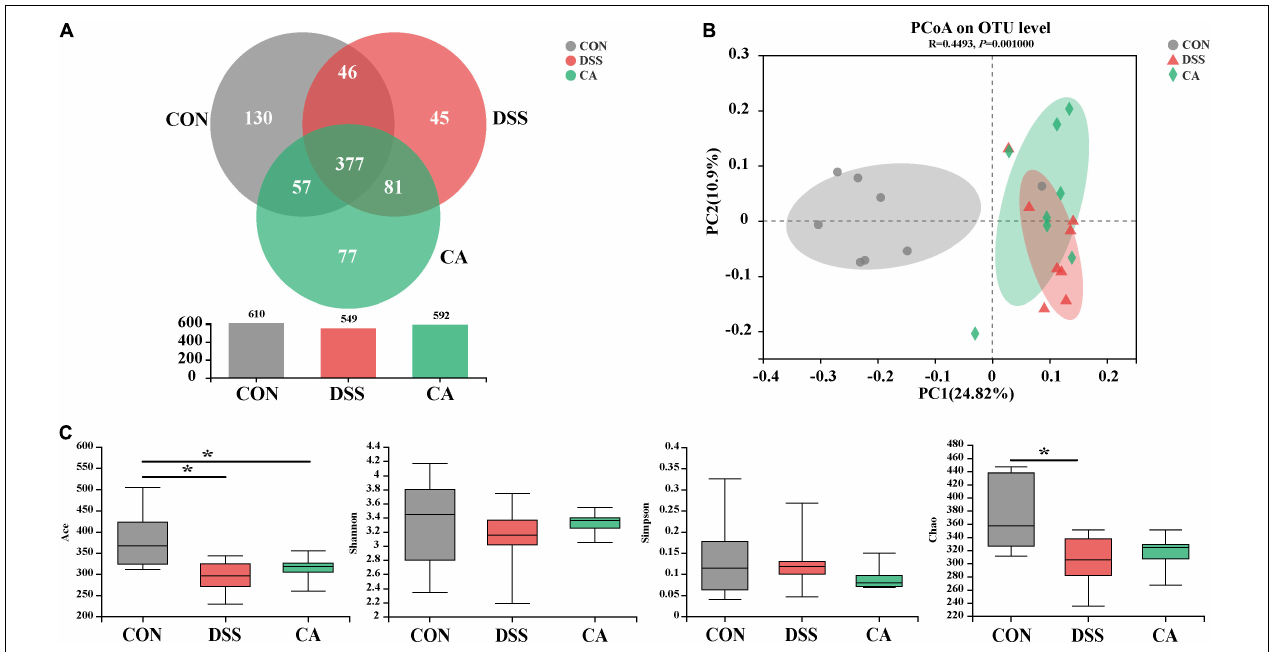
FIGURE 5 | Effects of CA administration on intestinal microbiota inflammation in DSS-induced colitis mice. (A) A Venn diagram showing the overlap of the operational taxonomic units (OTUs) identified in the intestinal microbiota among three groups; (B) principal coordinate analysis (PCoA) plot of the gut microbiota based on weighted Unifrac distance; (C) α -diversity of each group. Data are presented as mean ± SEM. ( n = 8 mice). * p <